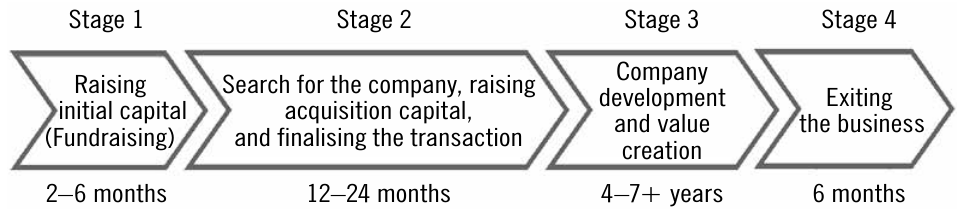
Figure 3. Search fund investment